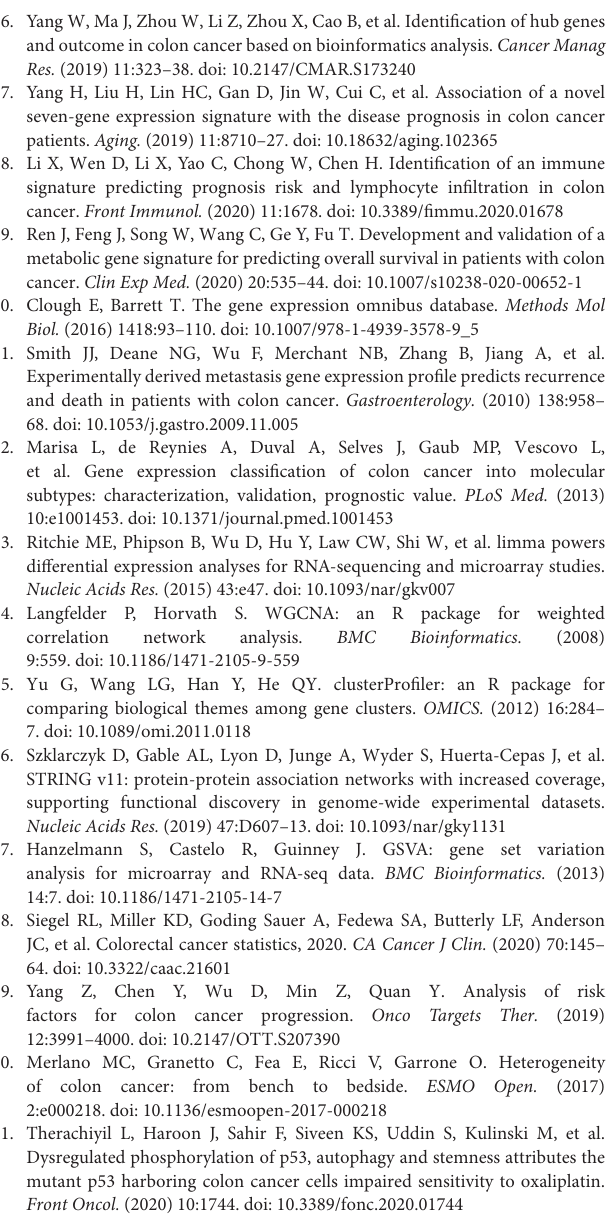
Supplementary Table 3 | The topological properties of the nodes in the PPI